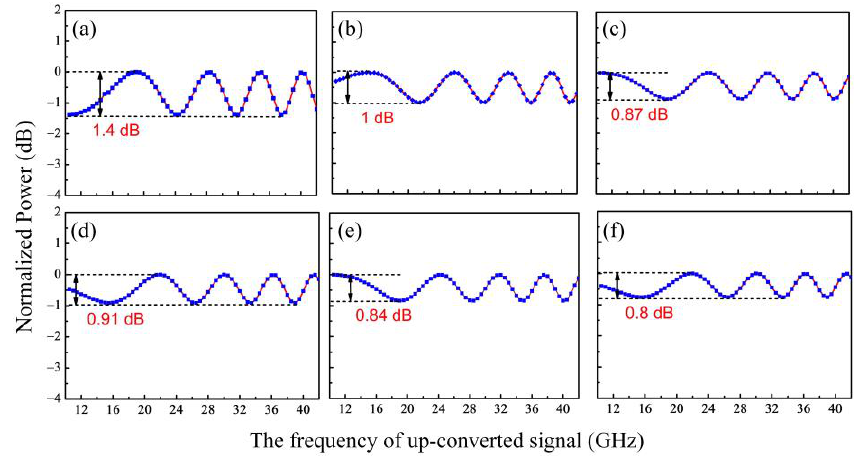
Figure 5. Frequency response of the microwave photonic mixer obtained by carrying out numerical calculations under different parameter deviations. ( a ) Extinction ratios of the parent-MZM and the sub-MZMs in the DP-DPMZM are 22 dB and 20 dB, respectively. ( b ) Bias-voltage deviation of the four sub-MZMs in the DP-DPMZM are 7%, 4%, 14% and 4%, respectively. ( c ) Amplitude imbalance of the PS is 0.4 dB. ( d ) Phase deviation of the PS is 6°. ( e ) Amplitude imbalance of the 90° HC is 0.4